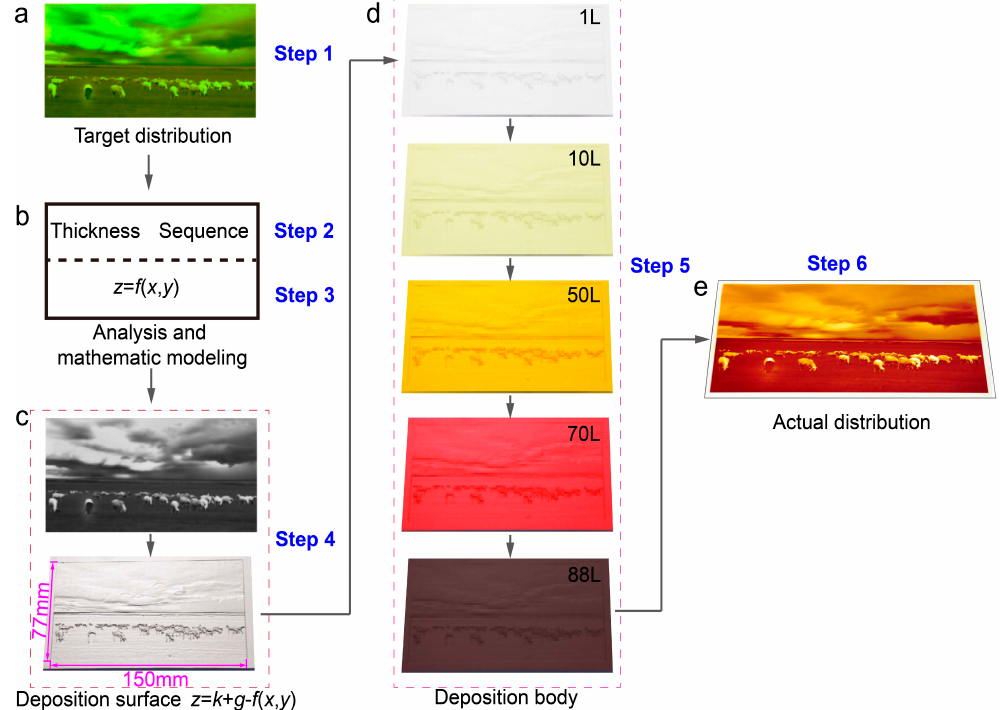
Figure 5. Distribution of a landscape photo via LMP-method. ( a ) Target distribution, a random digital photo of landscape with the length × width of 150 × 77 mm 2 . ( b ) Analysis and mathematic modeling to determine deposition sequence, thickness of each layer, and a function of z = f ( x , y ). ( c ) Fabrication of deposition surface ( z = k + g − f ( x , y )) via carving technology according to grayscale image of the photo. ( d ) The implement of deposition process, selected photo is the first 1, 10, 50, 70, and 88 layer, respectively. The deposition body is formed after the deposition of 88 layers. ( e ) Actual distribution obtained from a certain section ( z = g ) through machining the deposition